Question: Generate an informative caption for the figure above.
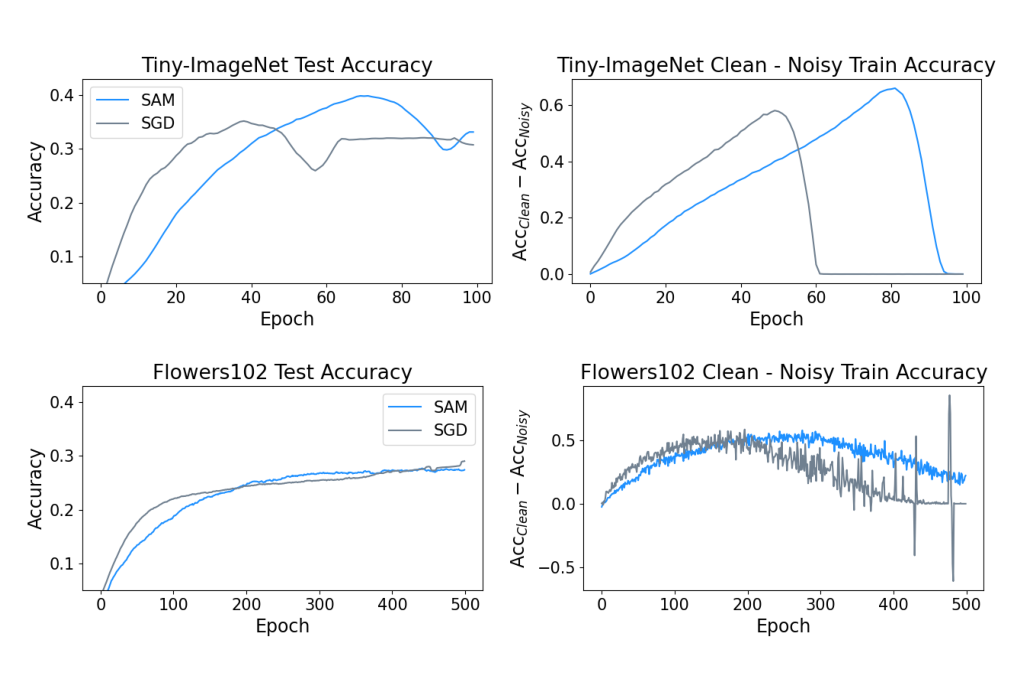
Answer: SAM observes higher true accuracy of noisy examples and this corresponds with better test accuracy on Tiny-ImageNet with 30% label noise and Flower102 with 20% label noise. Do note that contrary to trends in CIFAR10, in a low data settings such as Flowers102, the test accuracies of SAM and SGD do not drop even when the model starts to overfit. Models are ResNet18.